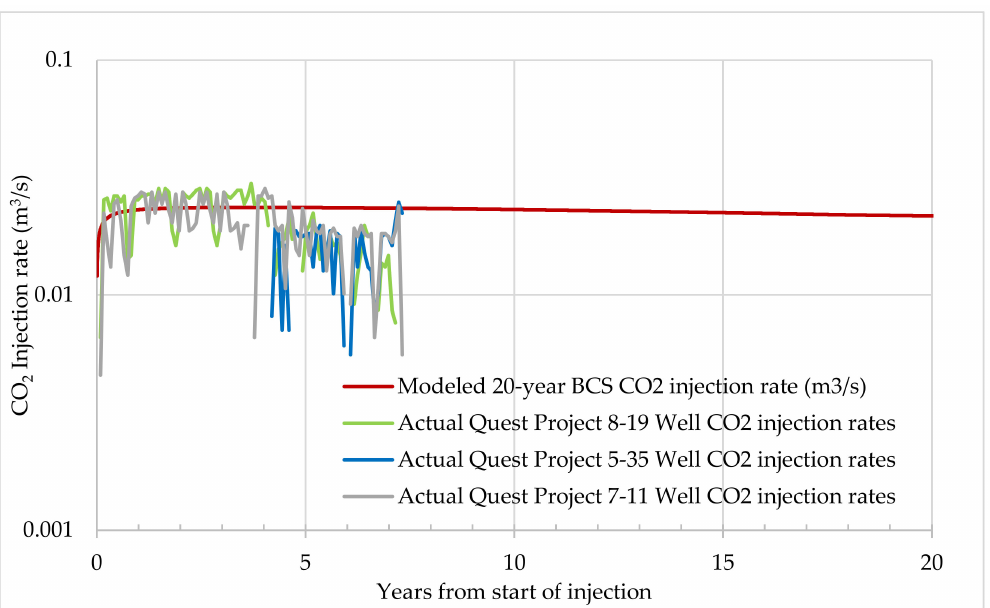
Figure 7. Comparison between the ResFrac™ model’s predicted per-well CO 2 injection rate for the Basal Sandstone Unit over a 20-year period (red line) and the actual CO 2 injection rates expe- rienced at the three CO 2 injectors operating at the Quest project in Alberta (grey, blue and green lines). Zero or near-zero injection rates corresponding to operational variables (such as well mainte- nance/workovers, plant maintenance/turnaround and operational upsets) were removed from the Quest injection